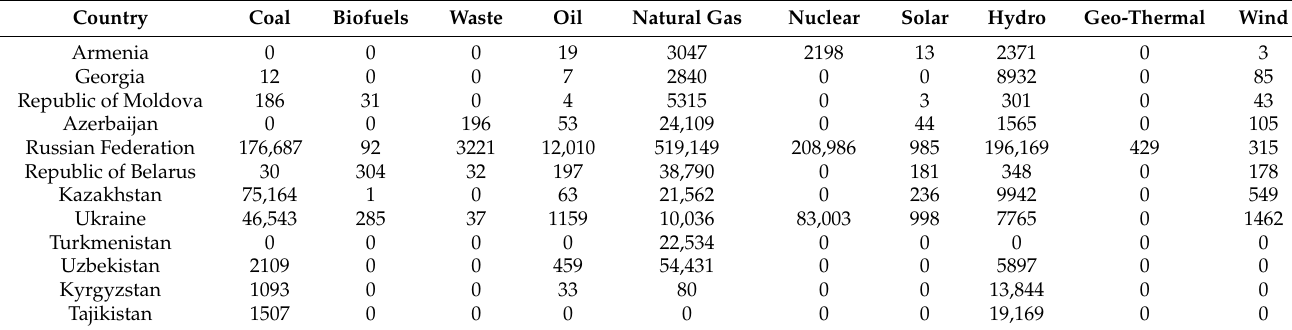
Table 1. Electricity generation by sources in Eastern Europe, Caucasus and Central Asia (EECCA) countries in 2019, GWh. Country Coal